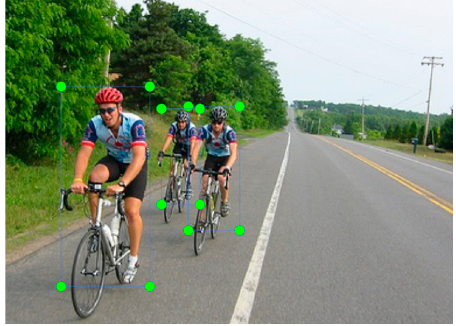
Figure 8. An example of images used for training the model.